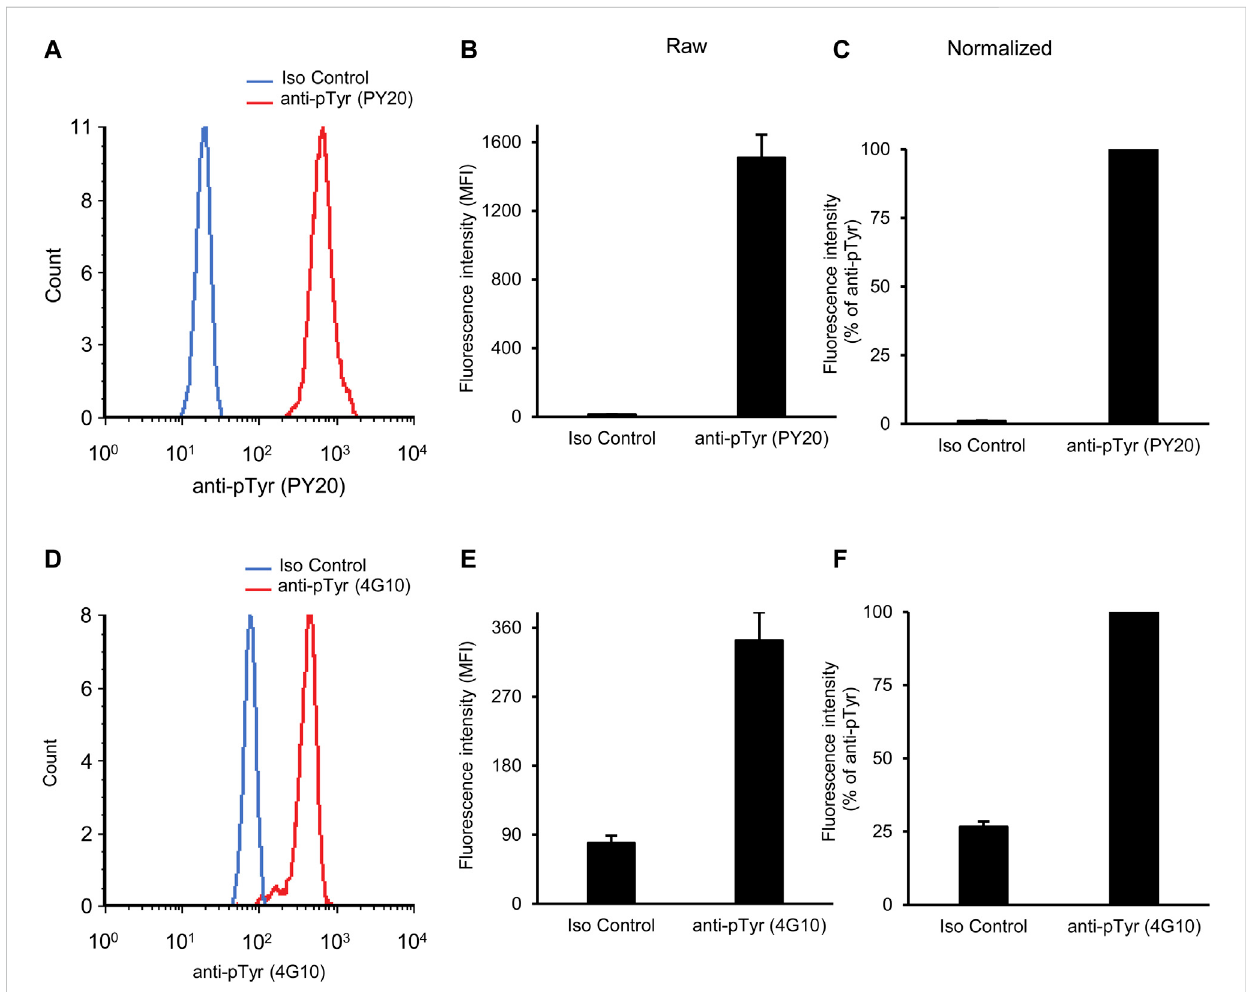
FIGURE 2 Basal tyrosine phosphorylation of circulating neutrophils. Blood was collected from untreated wild-type mice and stained with the PY20 (A – C) or the 4G10 (D – F) anti-phosphotyrosine antibodies along with isotype controls. Representative fl ow cytometric histograms (A, D) , raw quantitative fl uorescence values expressed as geometric mean fl uorescence intensity (B, E) and fl uorescence values normalized to those of anti-phosphotyrosine- stained samples (C, F) are shown. Bar graphs show mean and SEM from 14 (B – C) or 71 (E – F) mice from 8 (B – C) or 28 (E – F) independent experiments. MFI, geometric mean fl uorescence intensity; pTyr, phosphotyrosine; Iso,